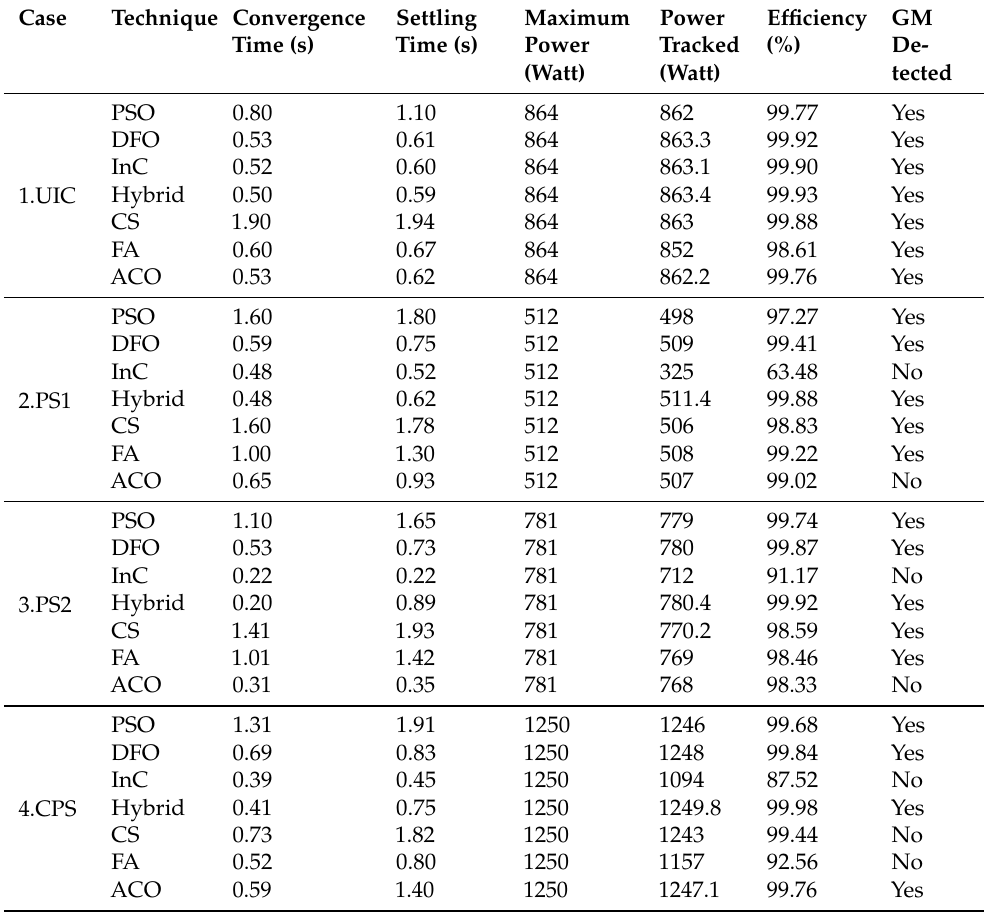
Table 3. Comparative Analysis between Proposed and Previous MPPT Techniques for all Weather